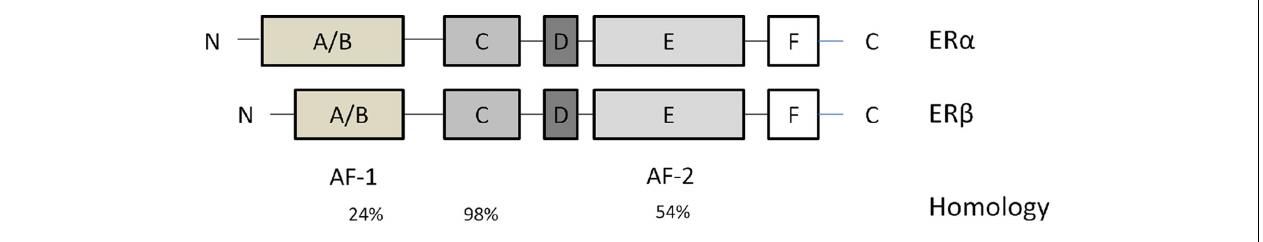
hinge region that provides flexibility between the C- and N- termini.The E and F domains contain the site that binds estrogen and estrogenic compounds. The percentage homology between different domains in these two isoforms is indicated below these